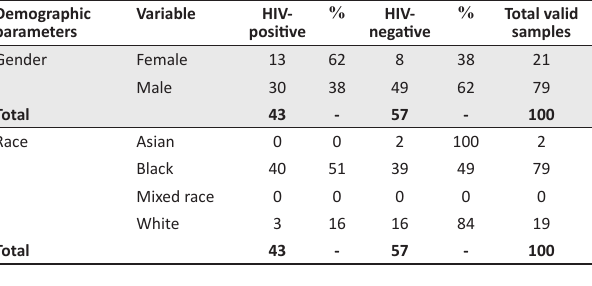
TABLE 2: Gender and race demographics for sudden, unexplained and unexpected death